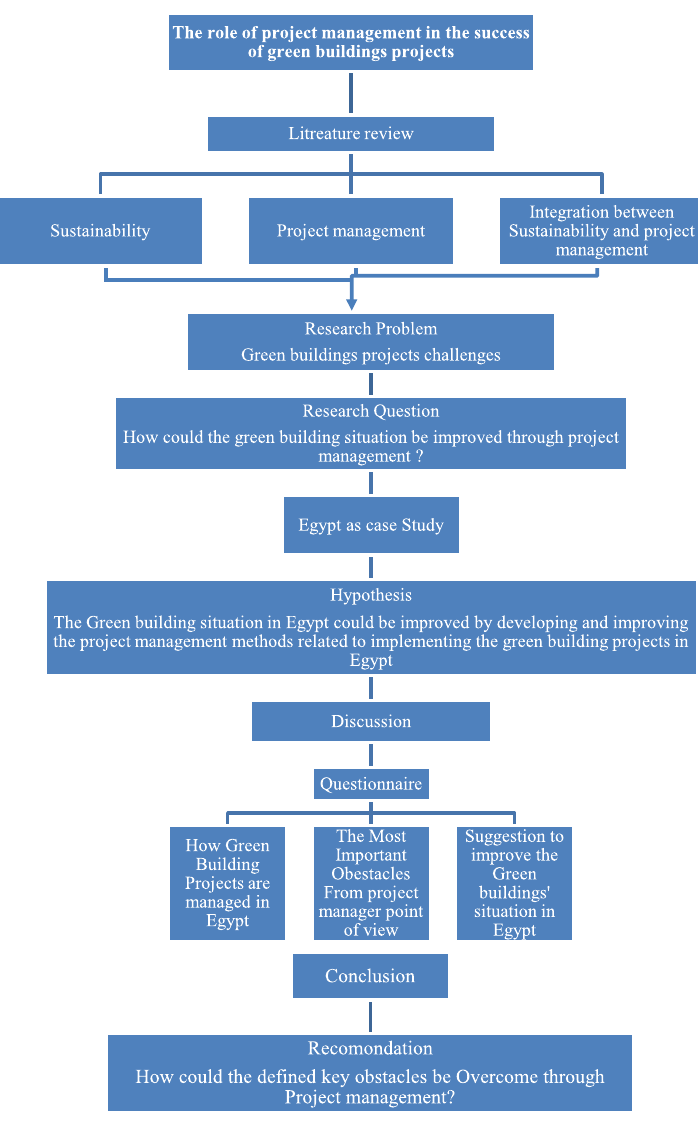
Fig. 1 Research method. Ref: